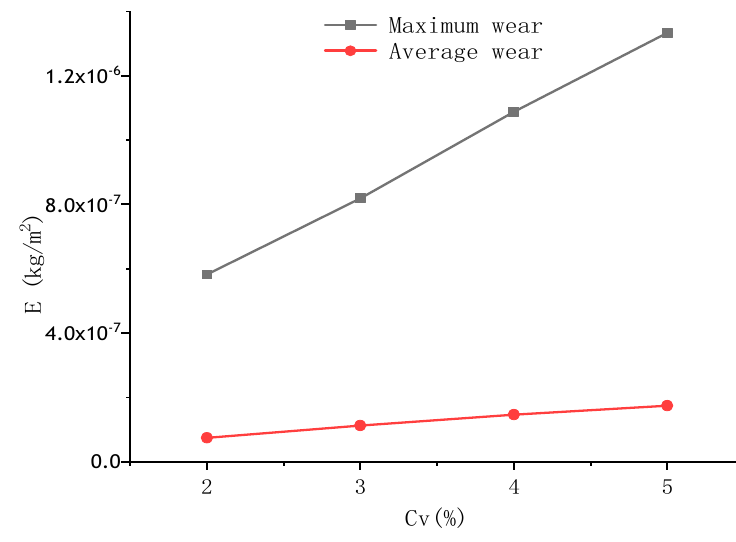
Figure 15. Wear curves of test samples with different particle volume fractions.